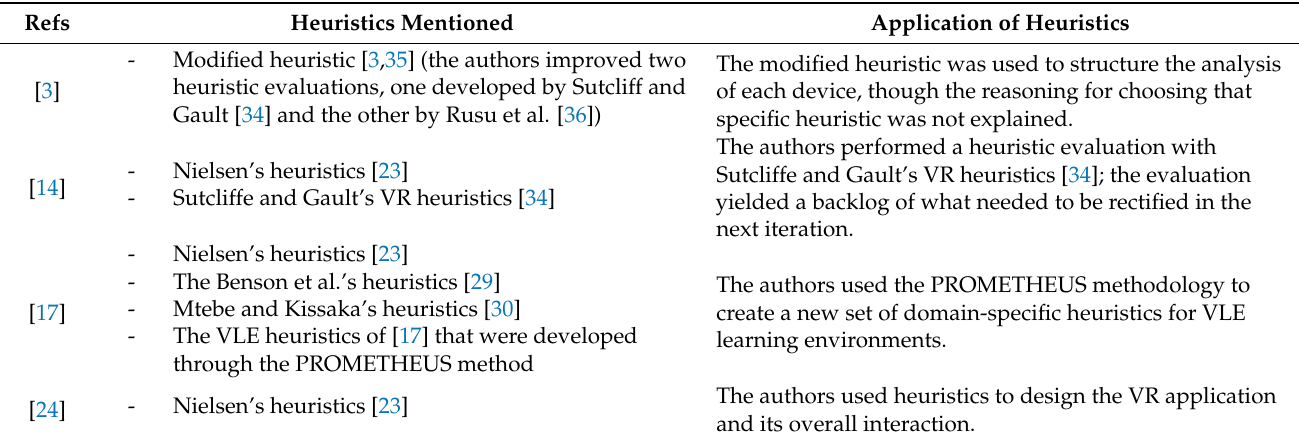
Table 1. Summary of how heuristics have been applied through the various